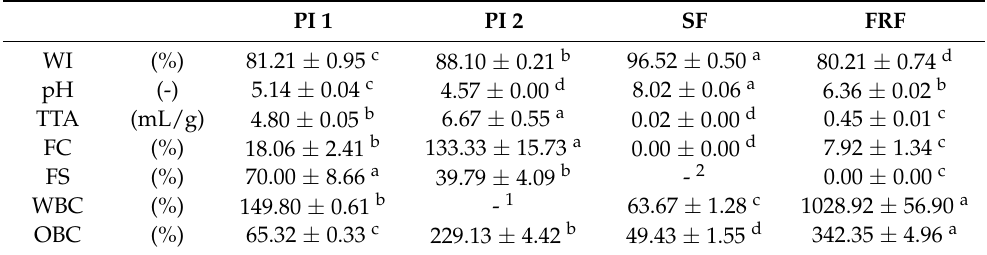
Table 4. Techno-functional properties of faba bean fractions, values ± standard